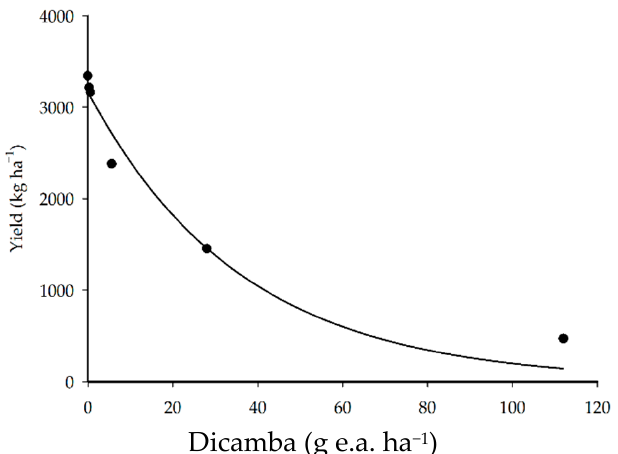
Figure 5. Soybean yield as a function of the application of dicamba doses. The application of lower doses (0.28 and 0.56 g e.a. ha − 1 ) resulted in a maximum of a 5% reduction in crop yield. The meta-analysis reported by Kniss [8] estimated that the dicamba dose needed to reduce soybean yield by 5% was 1.9 g e.a. ha − 1 for the V1–V3